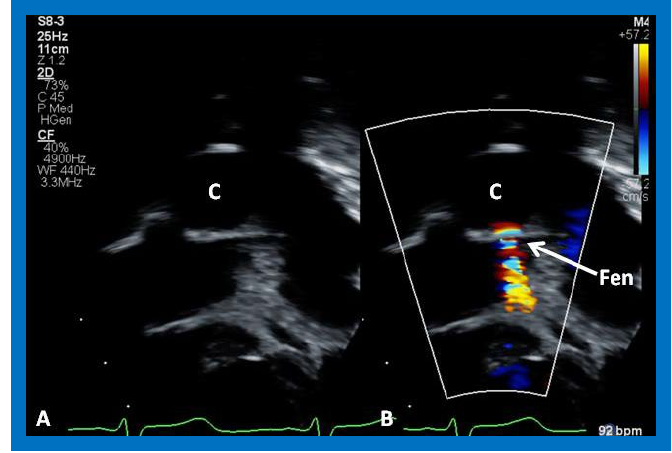
Figure 51. A magnified view of the fenestration (Fen), similar to Figure 50. C, conduit.